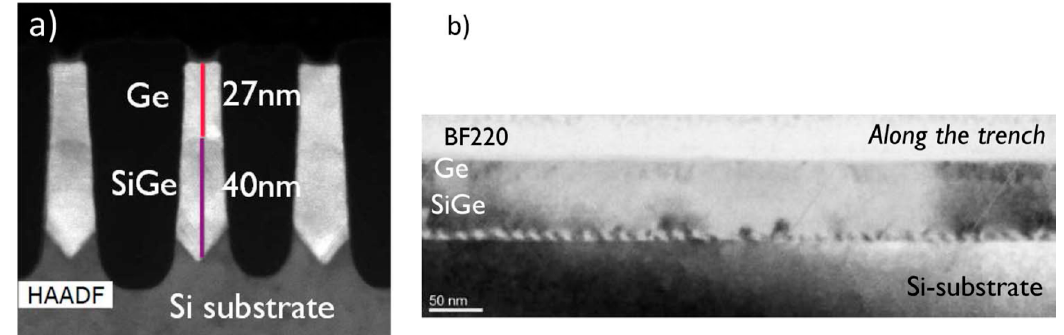
Figure 11. Cross-section TEM of strained Ge-cap/ SRB Si 0.3 Ge 0.7 grown in an oxide trench and observed